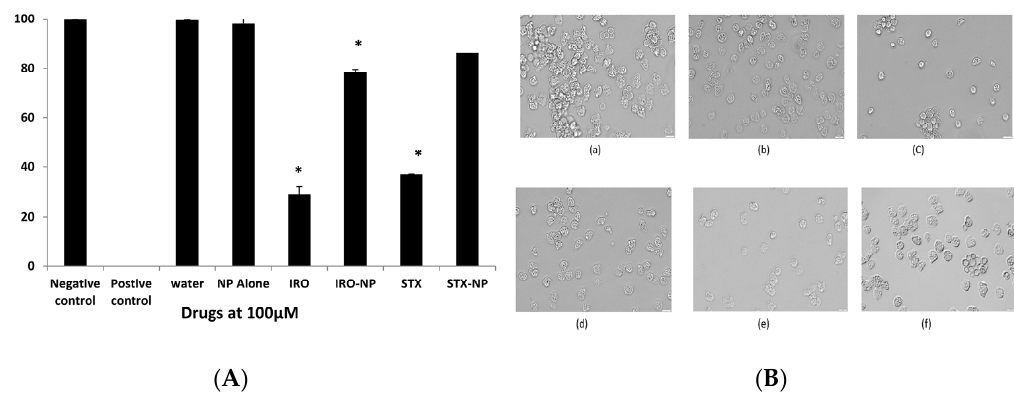
Figure 6. ( A ): Excystment experiments were conducted to examine the effects of the Irosustat (IRO), STX140 (STX), and their respective nanoparticles on A. castellanii excystation after noting the distinct impacts of Irosustat, STX140, and their respective nanoparticles. The findings are shown as the mean ± sem (* represents p < 0.05). ( B ) Microscopic analysis of A. castellanii after excystation assay with Irosustat, STX140, and their respective nanoparticles. ( a ) amoeba alone with RPMI (negative con- trol), ( b ) PLGA nanoparticles (placebo) along with amoeba—RPMI mix, ( c ) Irosustat along with amoeba—RPMI mix, ( d ) Irosustat nanoparticles along with amoeba—RPMI mix, ( e ) STX140 along with amoeba—RPMI mix, ( f ) STX140-NP along with amoeba—RPMI mix (200× magnification).